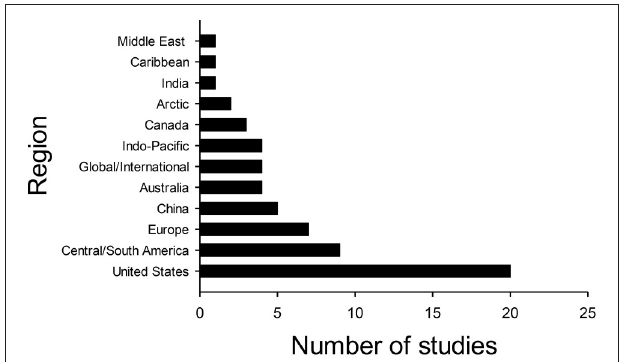
FIGURE 1 | Number of studies in various regions of the world in which proactive conservation was implemented or the need for such a strategy was